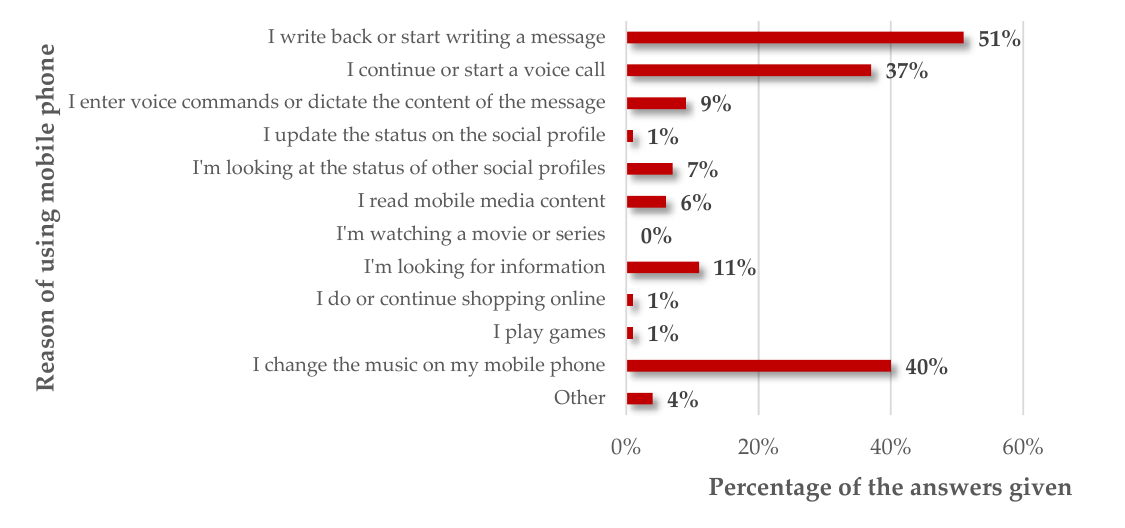
Figure 3. Typical goals of using a telephone as a driver while waiting for a green signal.